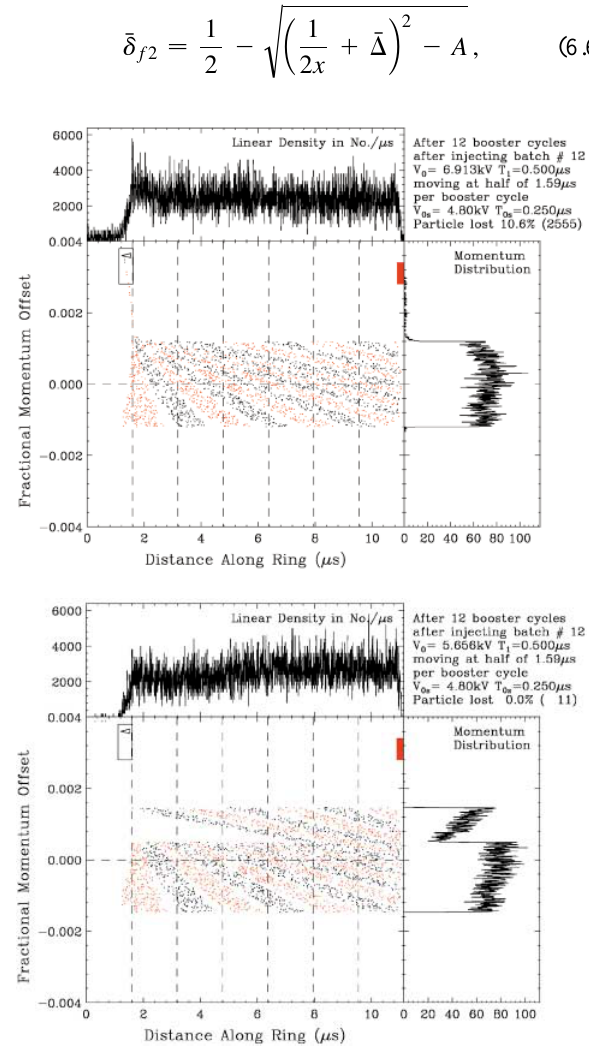
FIG. 9. (Color) Plots showing the moment one booster cycle after the injection of the 12th batch. Everything is the same as in the top plot of Fig. 8, except VT 1 of the moving barrier is increased by 10% in the top plot and decreased by 10% in the bottom plot. The width of the moving barrier is kept fixed at T 1 (cid:1) 0.5 m